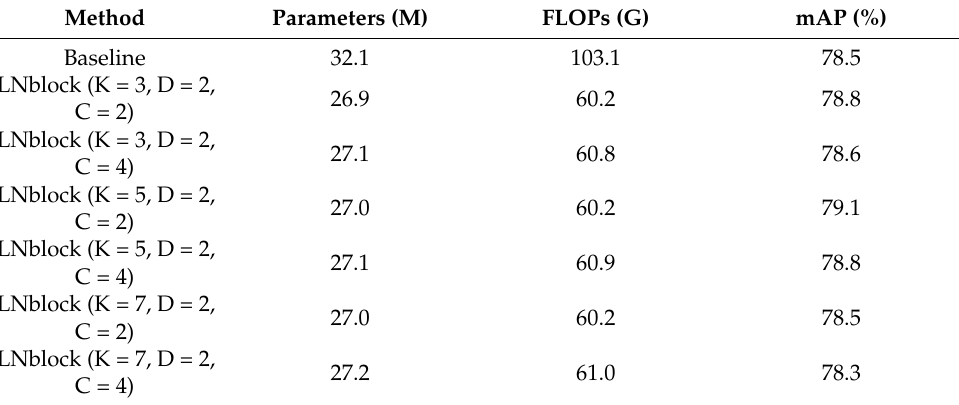
Table 5. Ablation study results of LNblock parameter analysis for the PASCAL VOC 2007 test dataset.